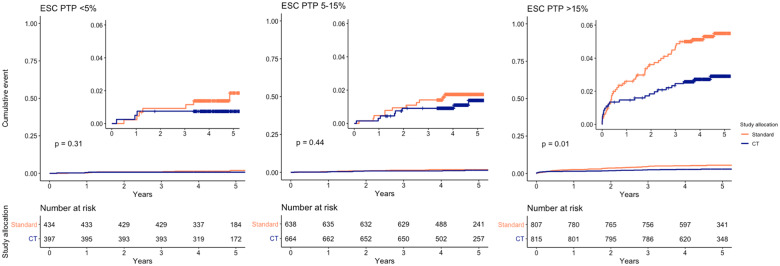
Cumulative incidence of coronary heart disease death or non-fatal myocardial infarction for each European Society of Cardiology pre-test probability category, stratified by study allocation. ESC, European Society of Cardiology; PTP, pre-test probability.